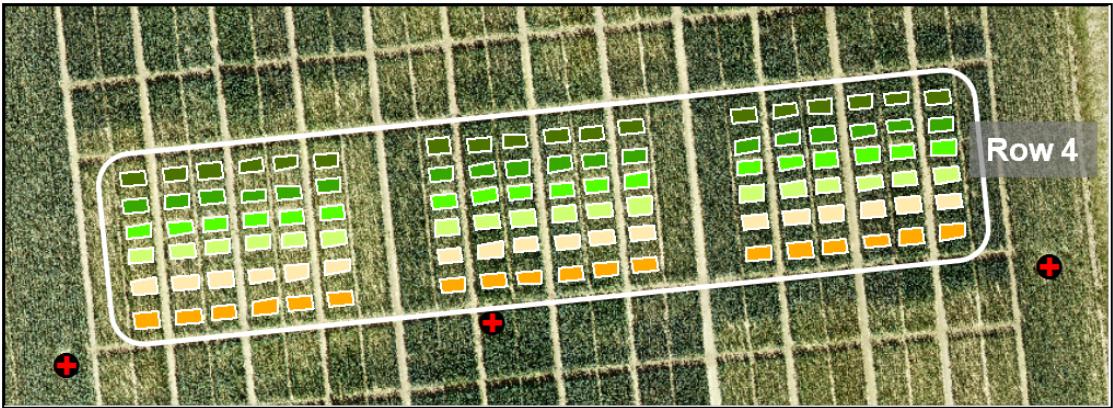
Figure 8. Image of 108 sampling plots (18 per date,